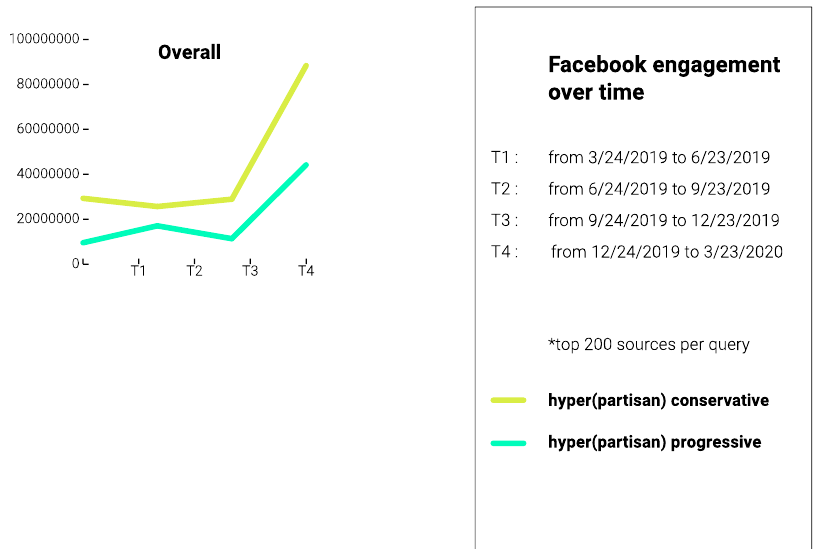
Figure 8. Facebook engagement scores of hyperpartisan conservative and hyperpartisan progressive sources for political candidate and social issue queries, overall, March 2019 - March 2020. Source: